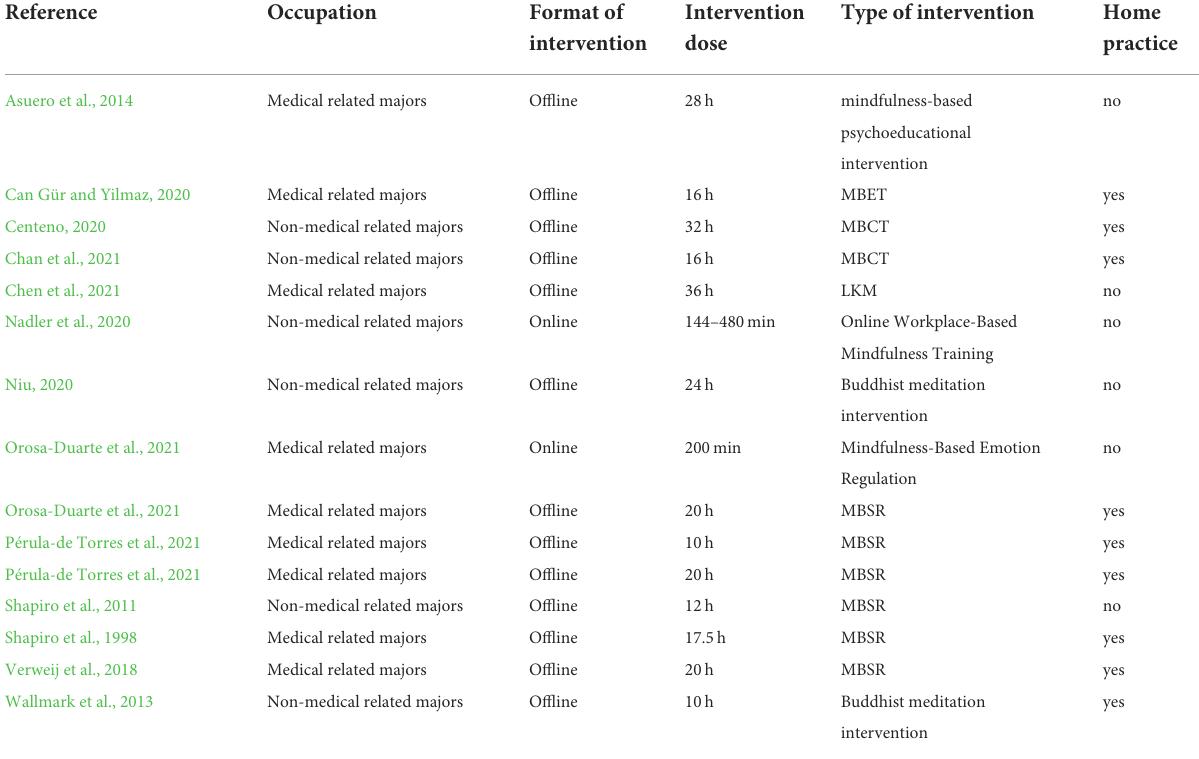
TABLE 2 Subgroup characteristics of the included